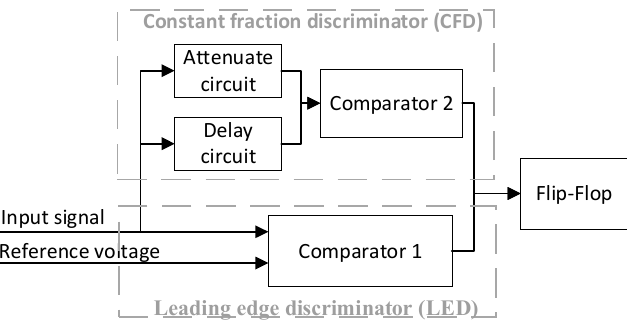
Figure 3. Schematic diagram of the timing discriminators.